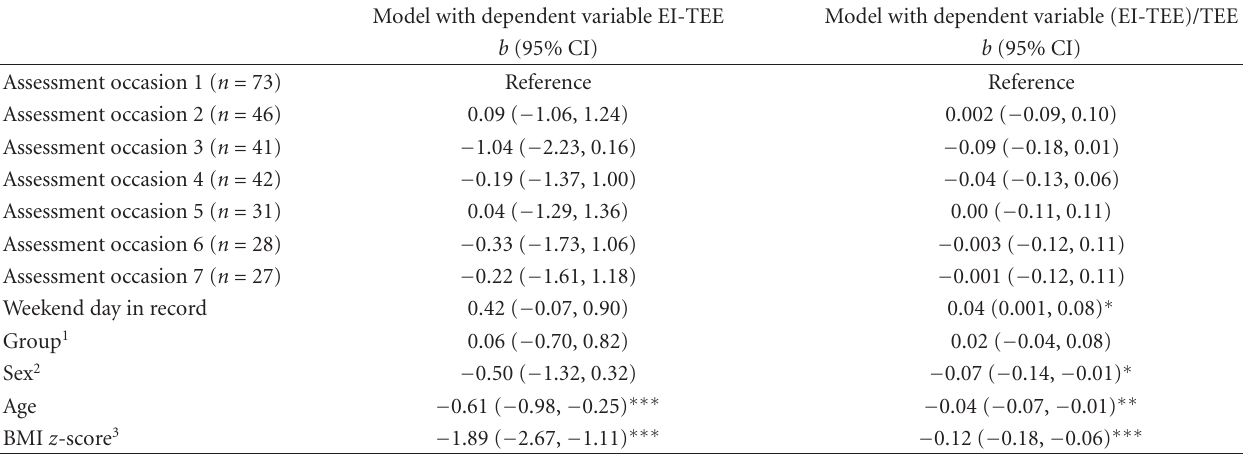
Table 3: Mixed model analyses of possible di ff erences in accuracy of assessed energy intake (EI) from estimated food records aided by digital camera compared with total energy expenditure (TEE) registered with SenseWear Armband, of children on 7 occasions during 2 years. Analyses were conducted with regard to presence of a weekend day in the record, group belonging (intervention or control group), sex, age, and BMI z